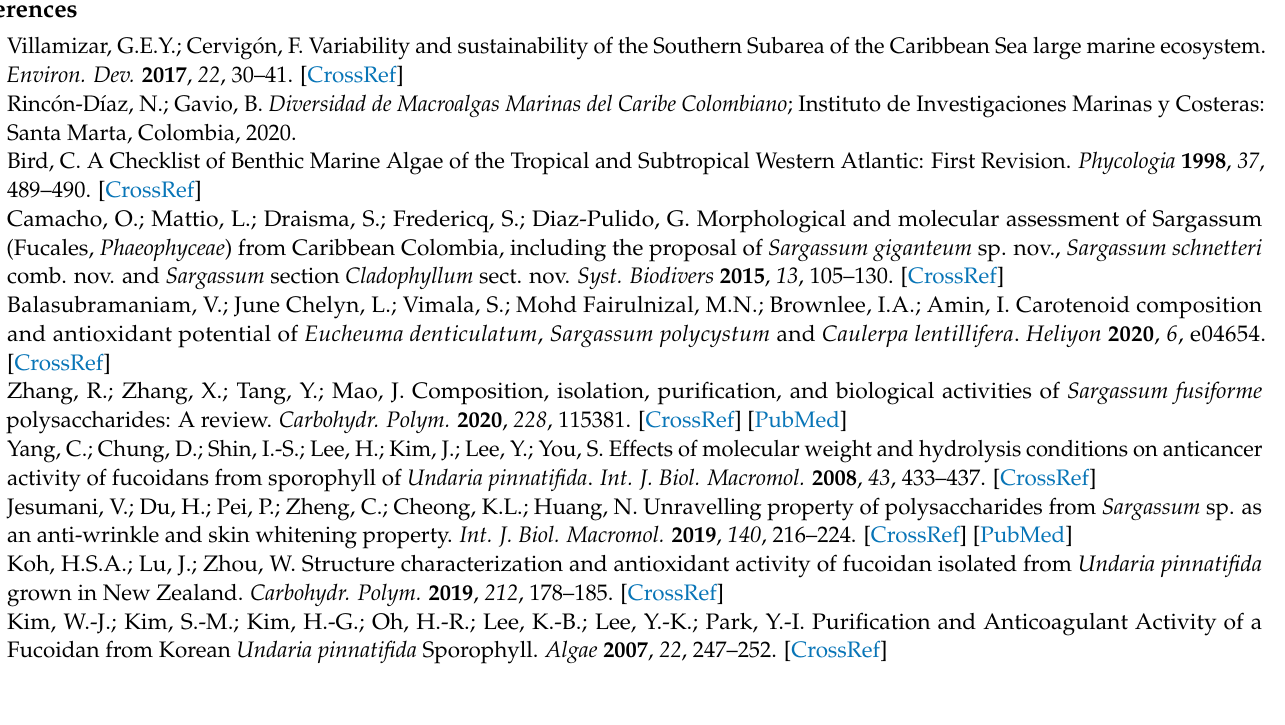
Figure S7: NMR 600 MHz 13C spectra of the type-phlorotannin polyphenol crude extract from S. filipendula